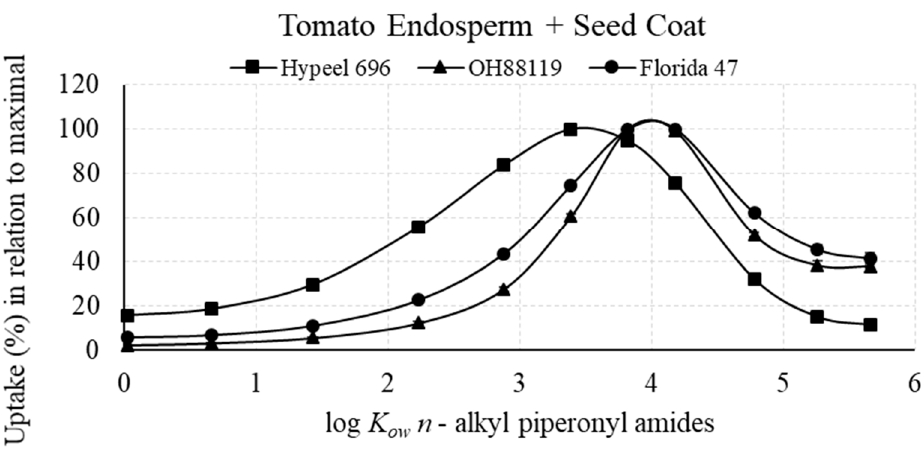
Figure 4. N -alkyl piperonyl amide uptake of tomato seed coat + endosperm in relation to maximal log K ow of 100%. Means with standard error bars are shown.